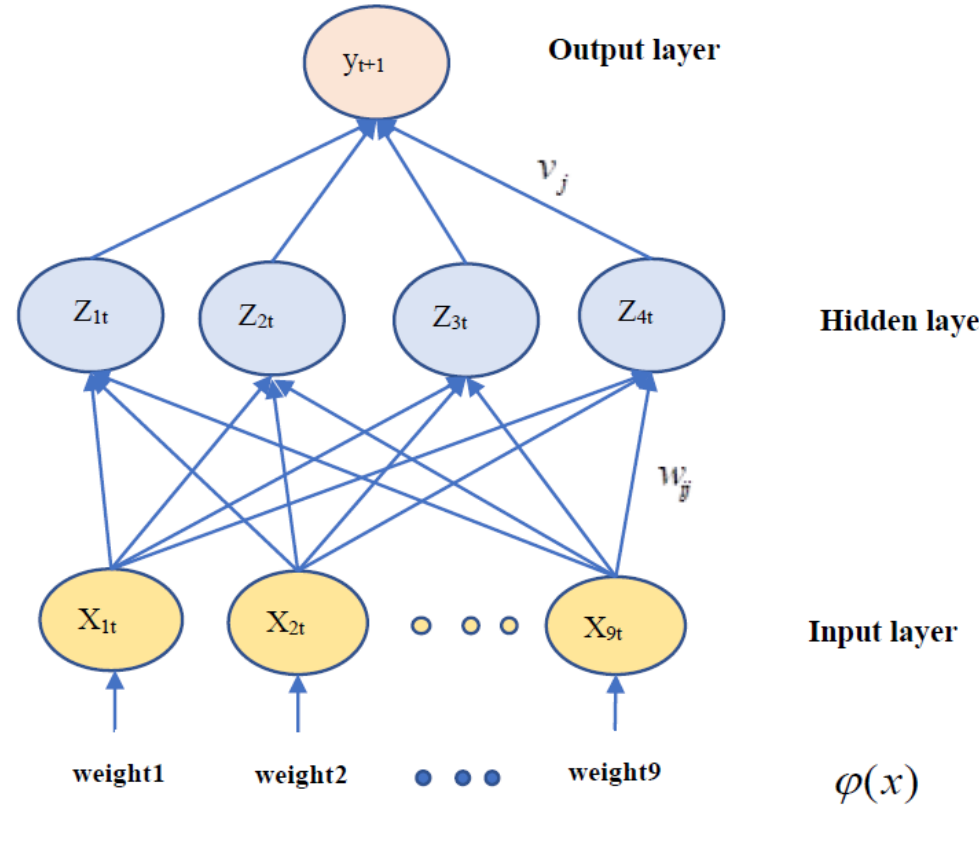
Figure 7. Topology of the WT-FNN neural network.